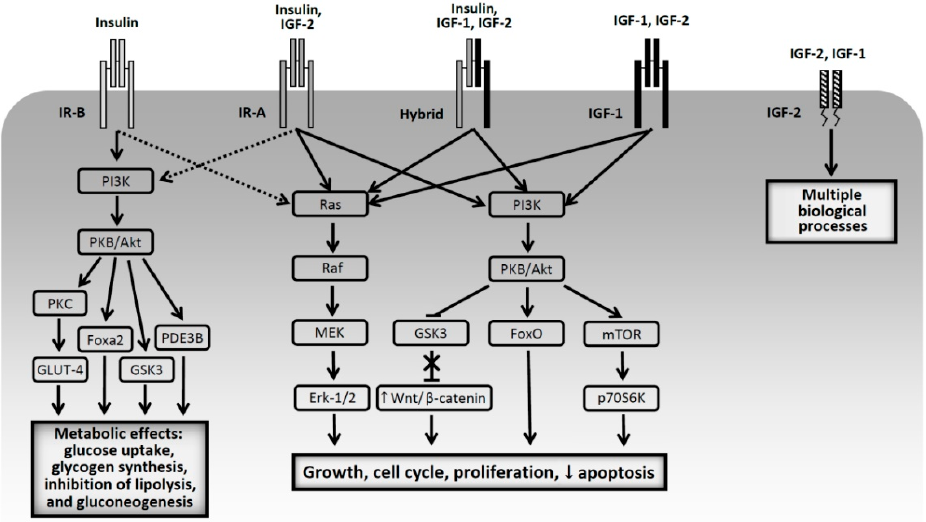
Figure 1. Schematic presentation of types of insulin and IGF receptors and post-receptor effects after binding to their ligands (based on [34–38,40]). PI3K—phosphatidylinositol 3-kinase; PKB—protein kinase B; PKC—protein kinase C; Fox—forkhead box protein; PDE3B—phosphodiesterase 3B; GLUT-4—glucose transporter-4; GSK3—glycogen synthase kinase 3; ERK— extracellular signal-regulated kinases; mTOR—mammalian target of rapamycin, p70S6—p70S6kinase. Solid lines: main pathways activated by ligand binding, dotted lines: additional